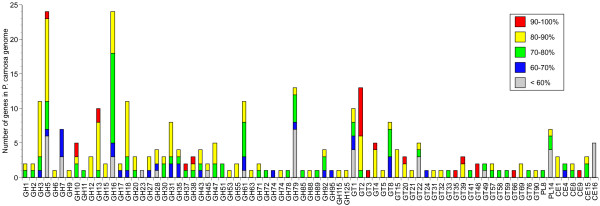
The distribution of percent identities of CAZyme members between P. carnosa and P. chrysosporium . For each query sequence ( P. carnosa  genes), the highest percent identity in blastp was scored. The numbers of  P. carnosa  genes are indicated according to the percent identities.